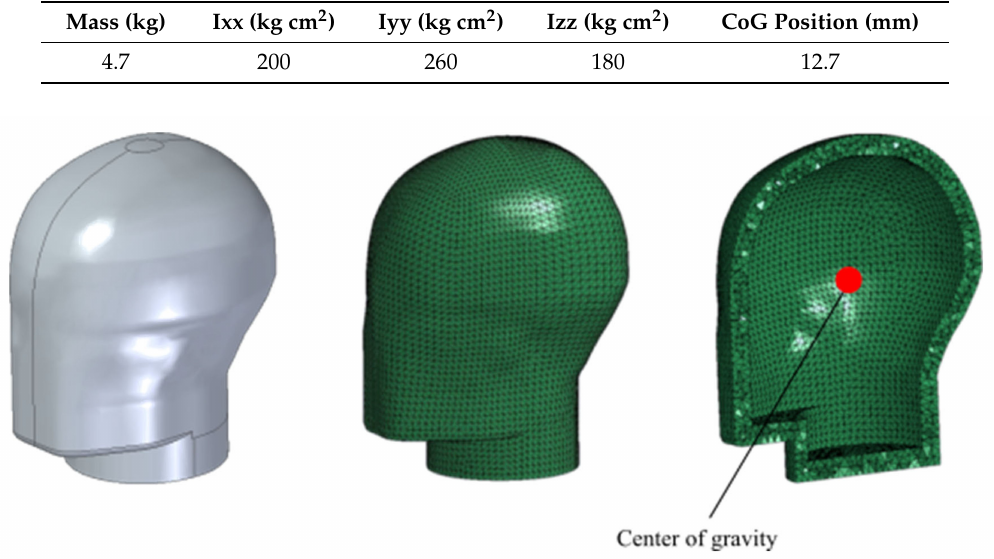
Figure 5. The head surrogate according to the ECE R22.05 standard, size J, and 4.7 kg